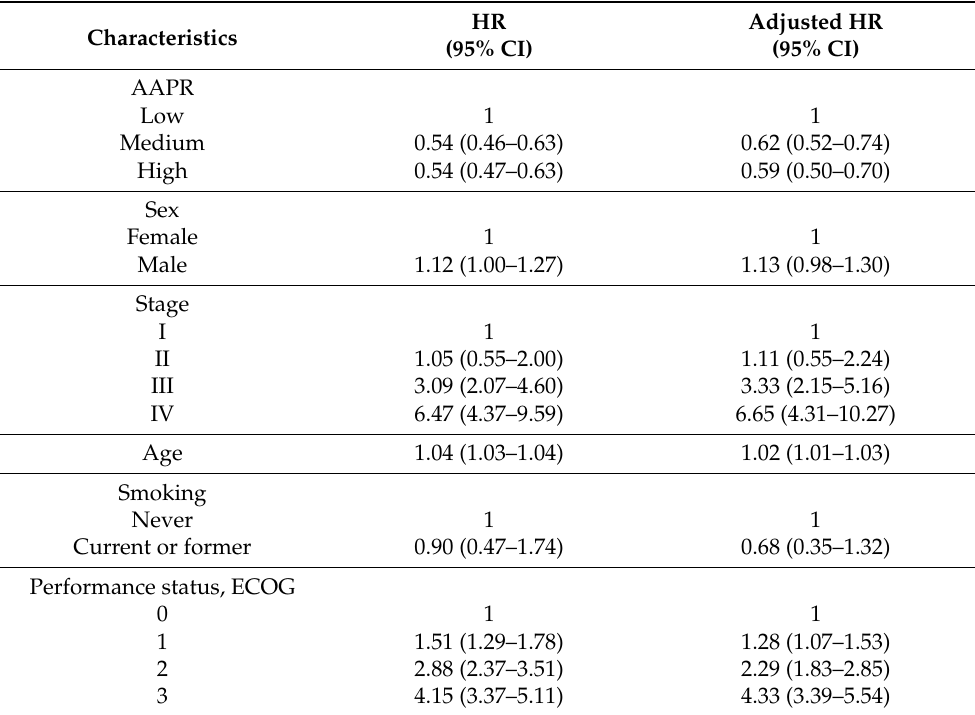
Table 5. Univariate and multivariate analyses of overall survival in SCLC patients ( N = 1099).